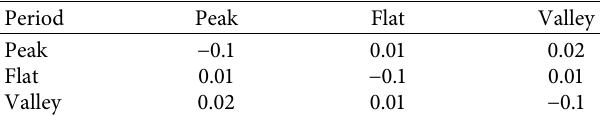
Table 2: Elastic coefcient